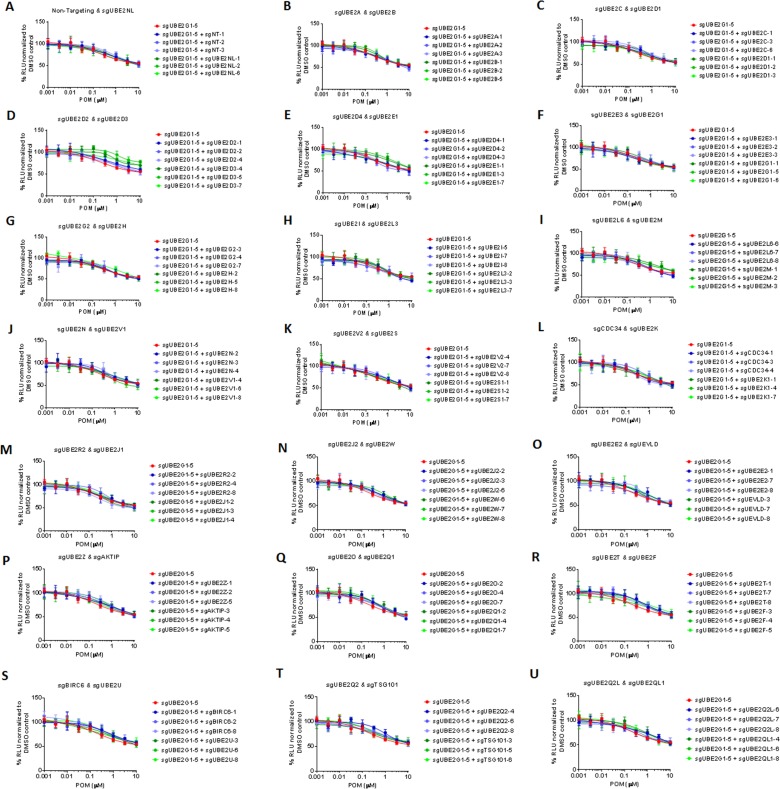
The effect of double knockout of UBE2G1 and one of the 41 E2 enzymes on pomalidomide-induced destruction of IKZF1.(A–U) Chemiluminescent measurement of ePL-IKZF1 protein expression level in U937_Cas9_ePL-IKZF1 parental cells or cells expressing both UBE2G1-specific and non-targeting or E2-specific sgRNA. Cells were treated with DMSO or an increasing concentrations of POM for 16 hr. Data are presented as mean ± SD, n = 4 technical replicates.10.7554/eLife.40958.011Figure 2—figure supplement 1—source data 1.ePL luminescence signal shown in Figure 2—figure supplement 1A–U.